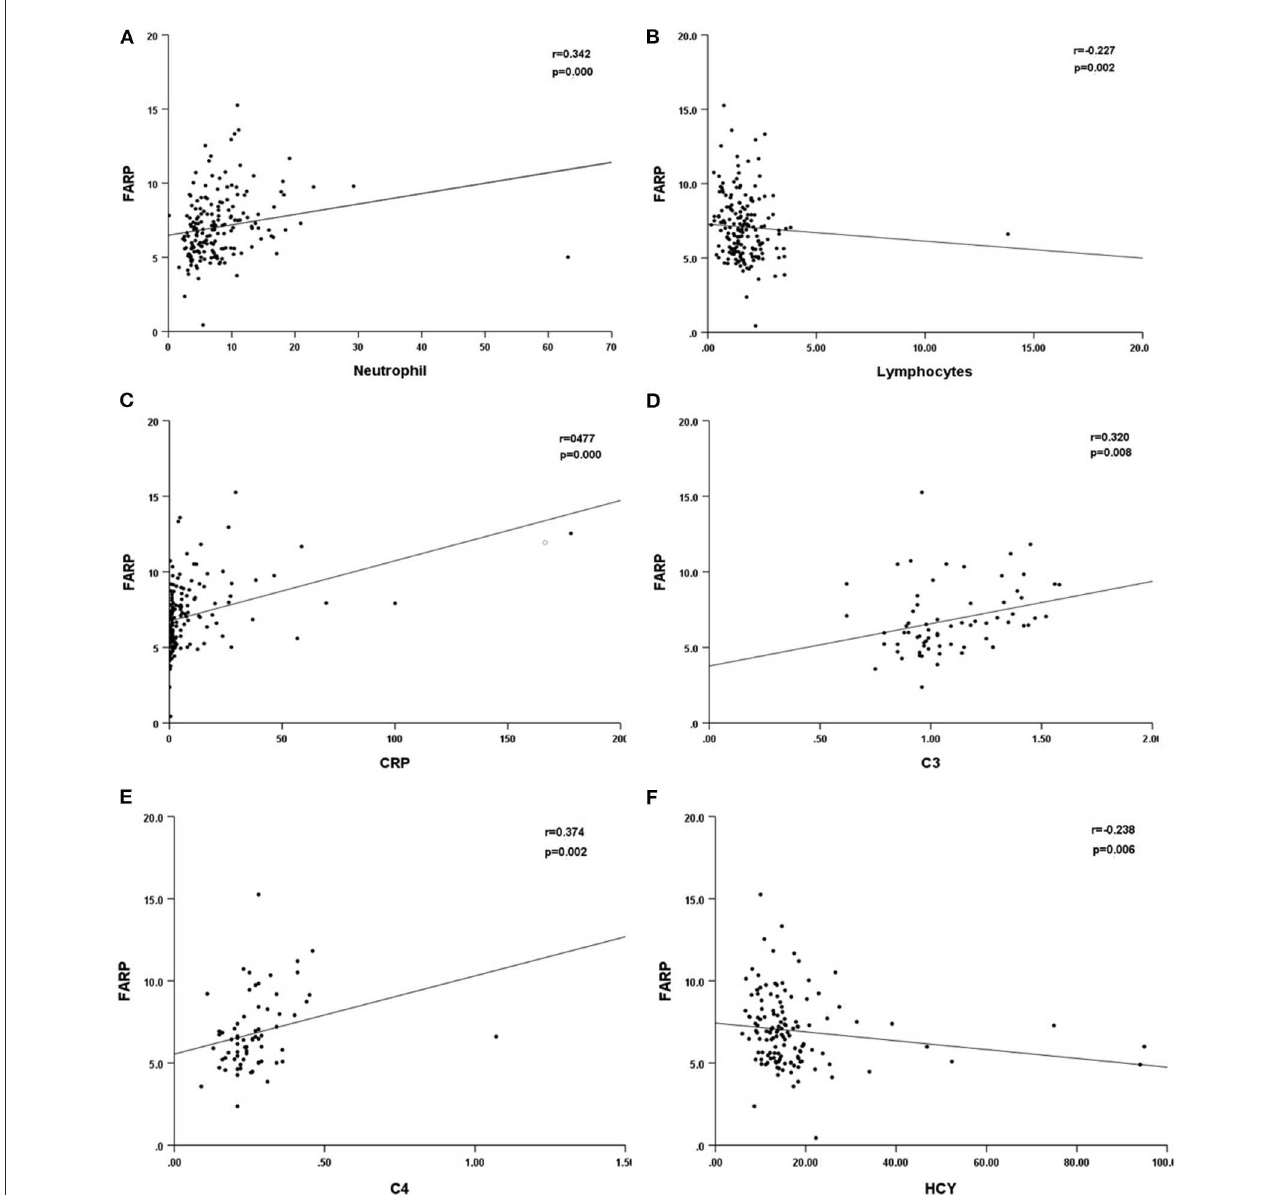
FIGURE4 Scatter plot of the correlation between neutrophil ( * 10 9 /L) (A) , lymphocytes ( * 10 9 /L) (B) , CRP (mg/L) (C) , C3 (D) , C4 (E) , HCY (F) and FARP level. CRP, C-reactional protein; C3, complement 3; C4, complement 4; HCY,